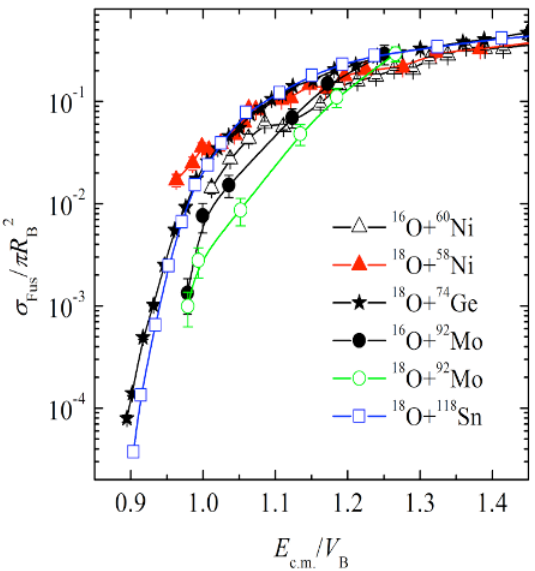
Figure 3. (Color online) Reduced fusion excitation functions for some typical systems